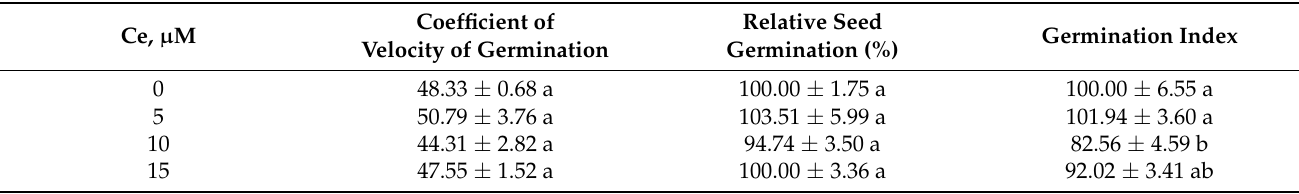
Table 2. Coefficient of velocity of germination, relative seed germination and index of tomato ( Solanum lycopersicum ) cv. Vengador seeds treated with cerium (Ce) under controlled conditions.